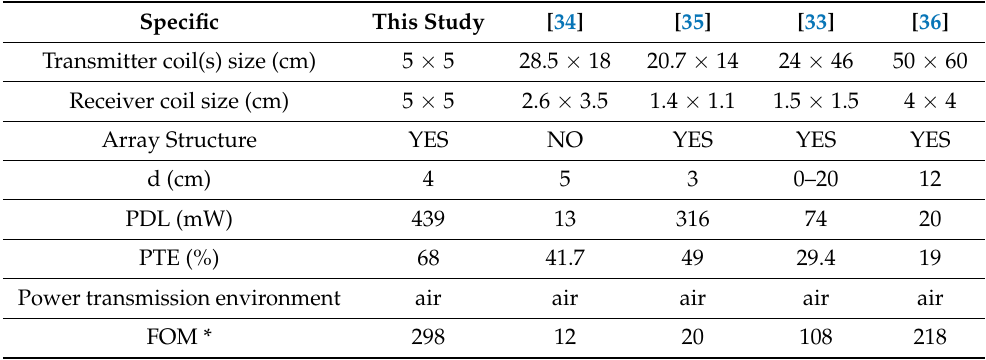
Table 2. A comparison between the proposed system and similar studies based on the main speci- fications of the system.